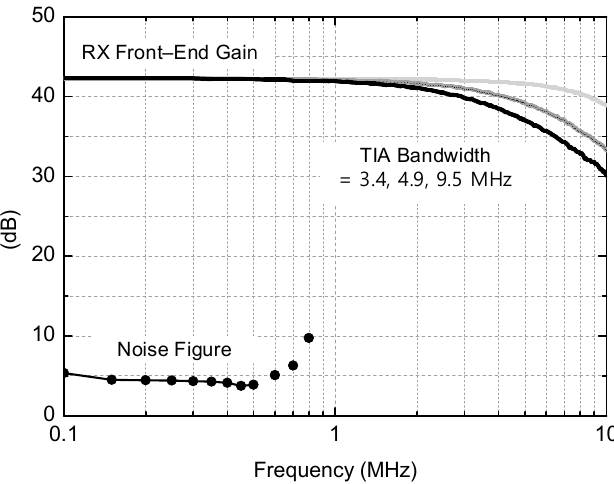
Figure 9. Measured gain and noise figure of the RF front end.